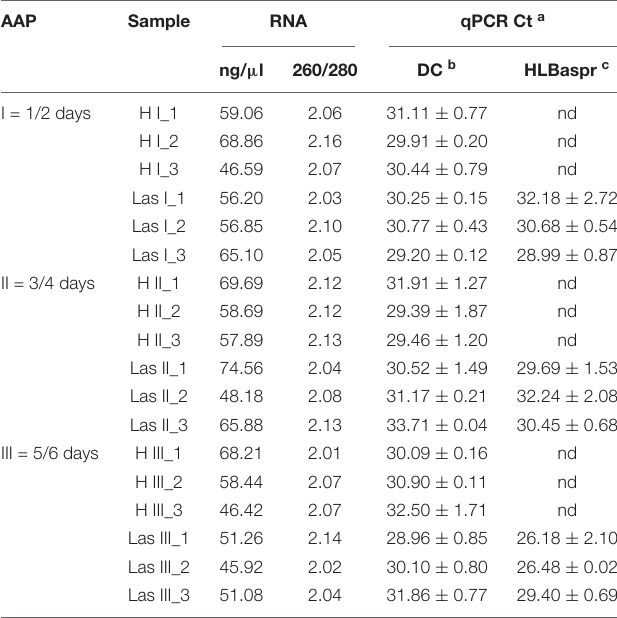
TABLE 2 | Spectrophotometrically measured RNA concentration (ng/ µ l) and quality (260/280) and detection of Diaphorina citri (DC) and “